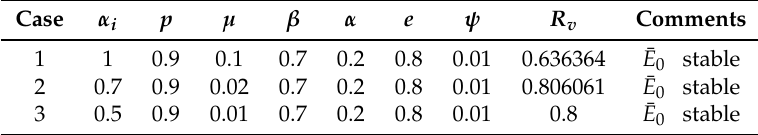
Table 2. Different parameter values used for SIS epidemic